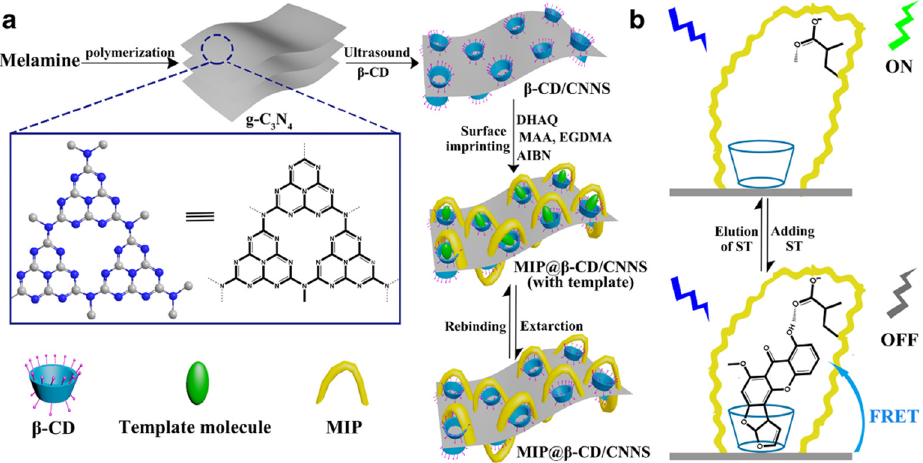
Figure 13. Schematic representation of the synthesis of MIP@ β -CD-modified carbon nitride nanosheets (CNNS) ( a ); and its application ( b ). Reproduced from the work in [134] with permission from Springer Nature.